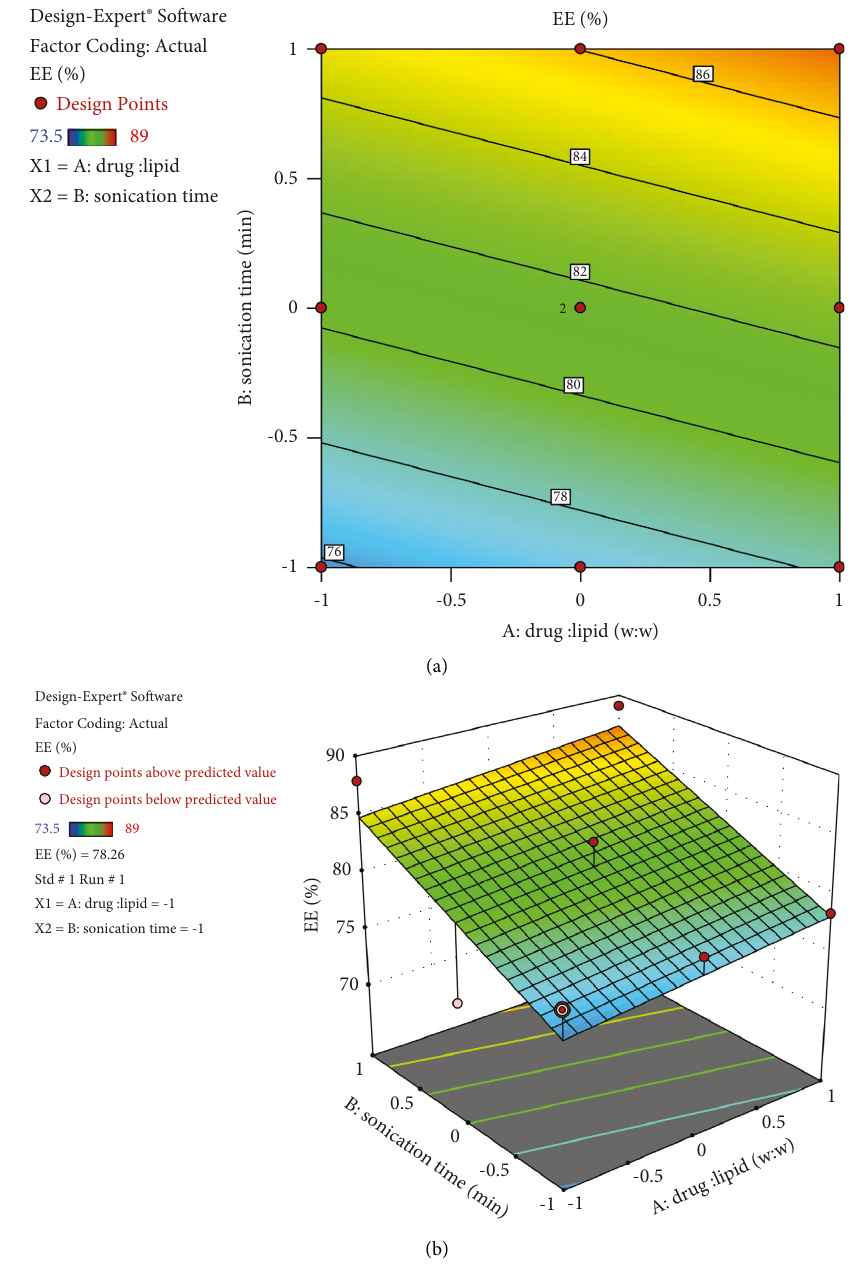
Figure 3: (a) Contour plot of entrapment efficiency (%) against drug: GMS ratio (w:w) and sonication time (min) and (b) 3D surface plot of entrapment efficiency (%) against drug: GMS ratio (w:w) and sonication time